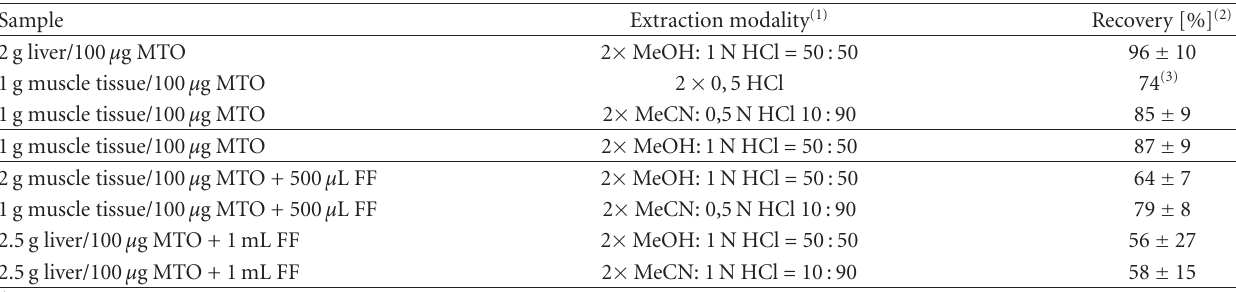
Typical extraction procedure: double incubation in ultrasonic bath, each for 10 minutes. Collecting the supernatant after centrifugation and HPLC- measurement afterwards. (2) number of independent experiments n = 3 (3) single experiment.